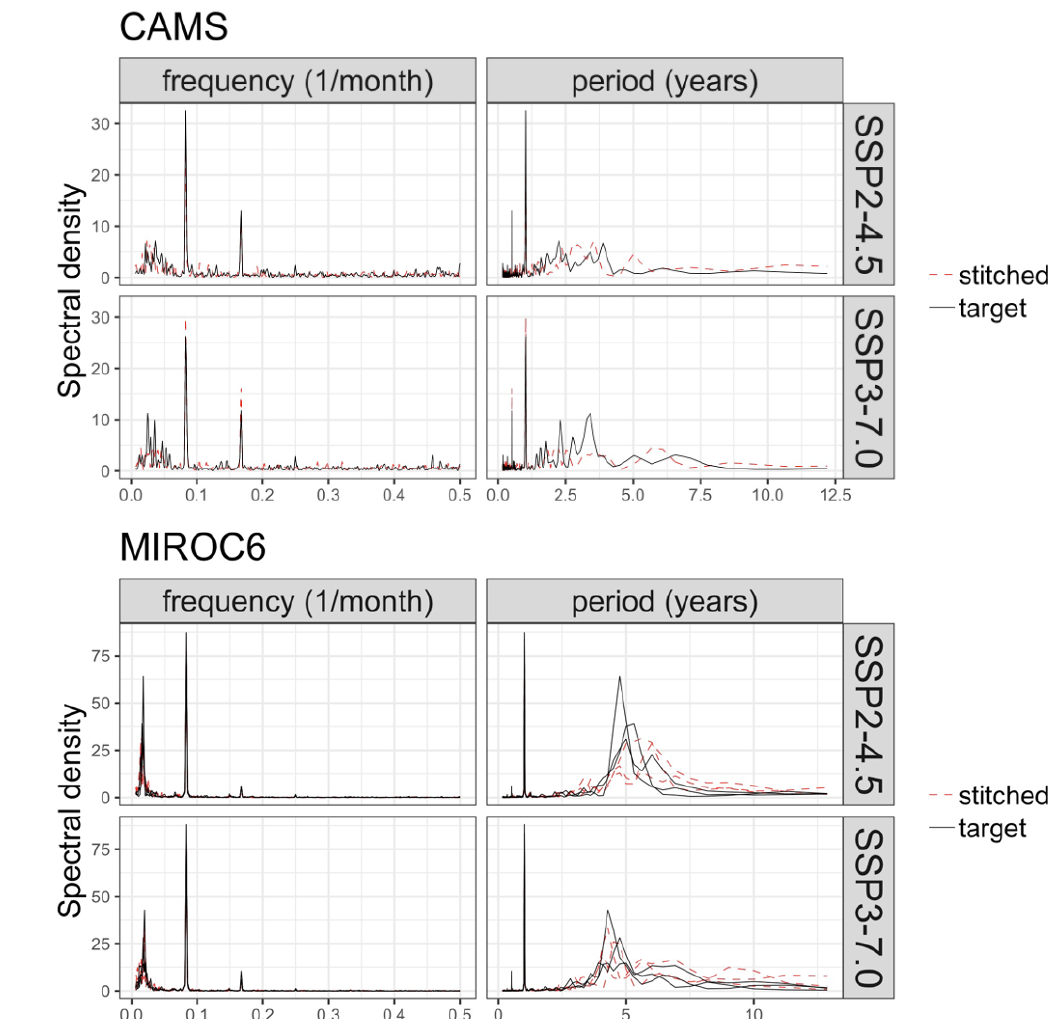
Figure D7. Spectral densities computed from target (solid lines) and stitched (dashed lines) SOI time series, for both models and one (for CAMS-CM-0, top four plots) and three (for MIROC6, bottom four plots) realizations.